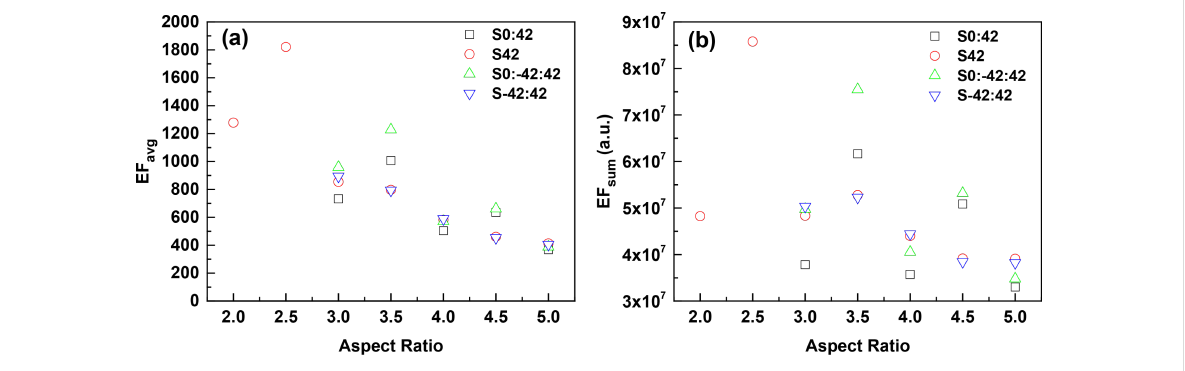
Figure 5: The average EFs (a) and the total EFs (b) of AgNR 2D hexagonal arrays with different structures and ARs. The excitation wavelength is 632.8 nm and the polarization is parallel to the y -direction.